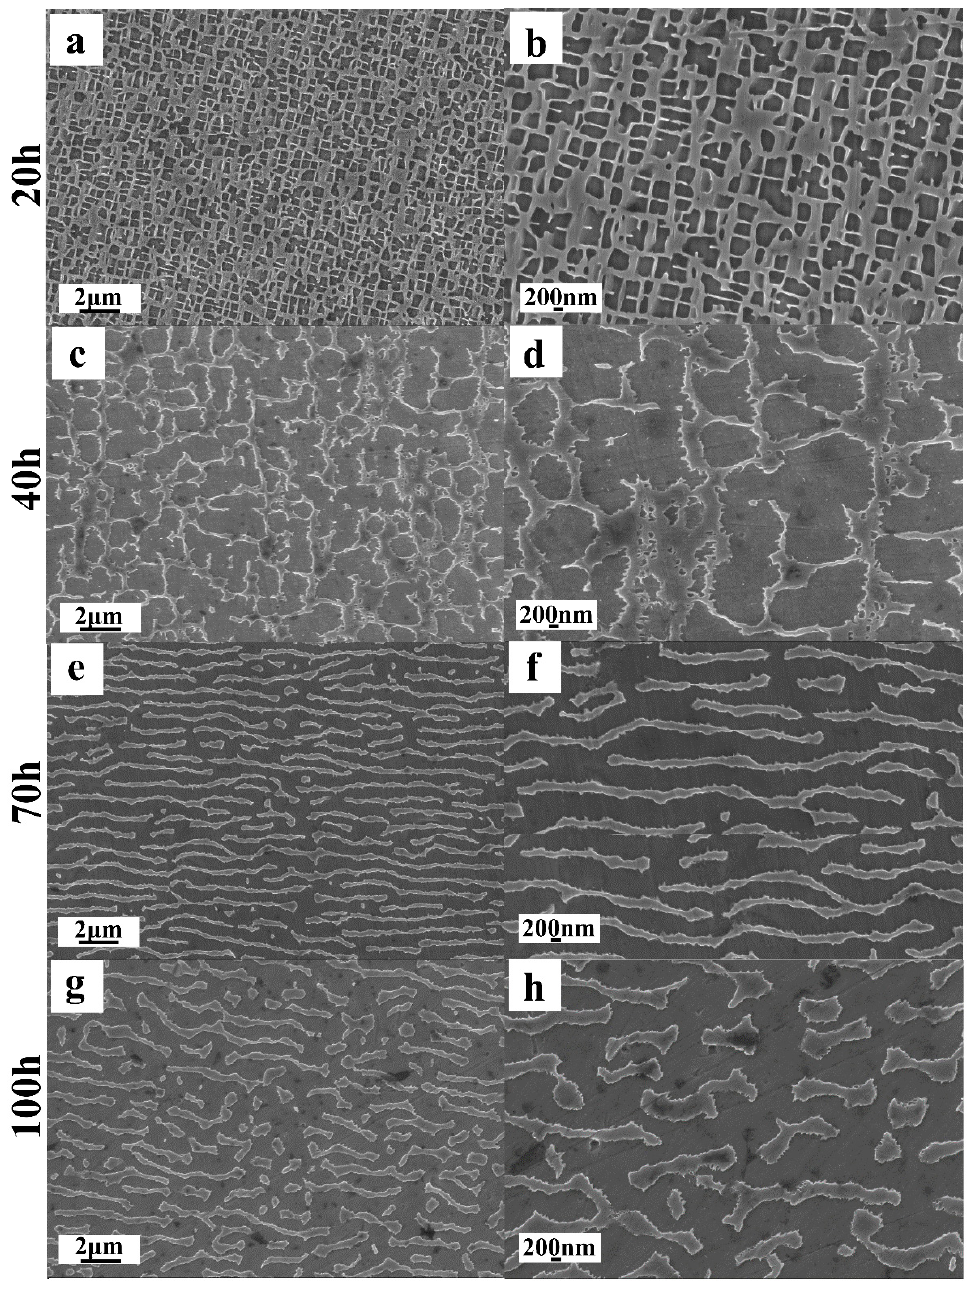
Figure 4. Microstructure of the tested alloy with creep mutation time of ( a , b ) 20 h ( c , d ) 40 h ( e , f ) 70 h ( g , h ) 100 h under 1050 °C/170 MPa.